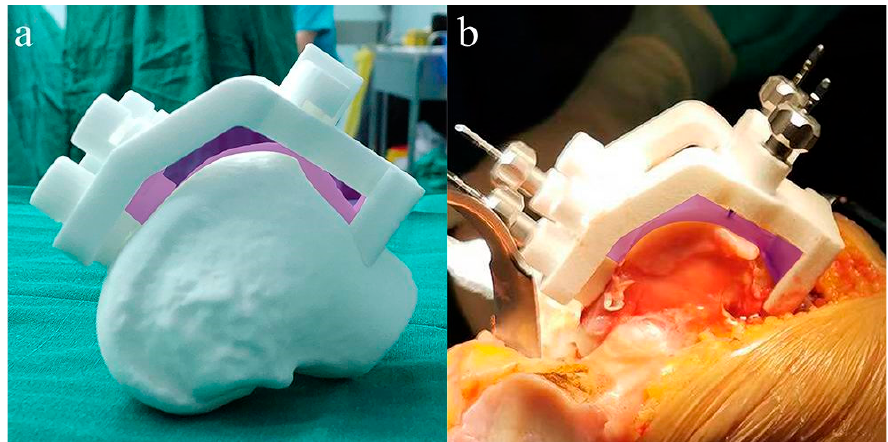
Figure 5. Comparison the gap between PSI and the printed bone ( a ) with that between PSI and native femur ( b ) is critical for the accuracy on the sagittal plane. The gaps were highlighted with translucent pink shadows.